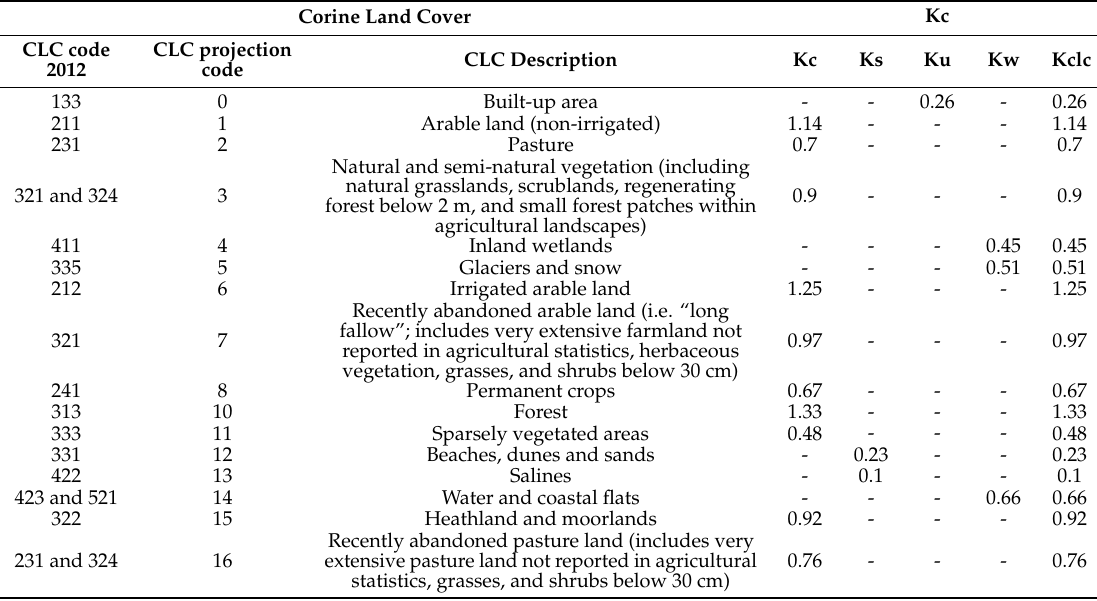
Table 5. Corine land cover classes and calculated annual Kc for future scenarios, in the Piedmont